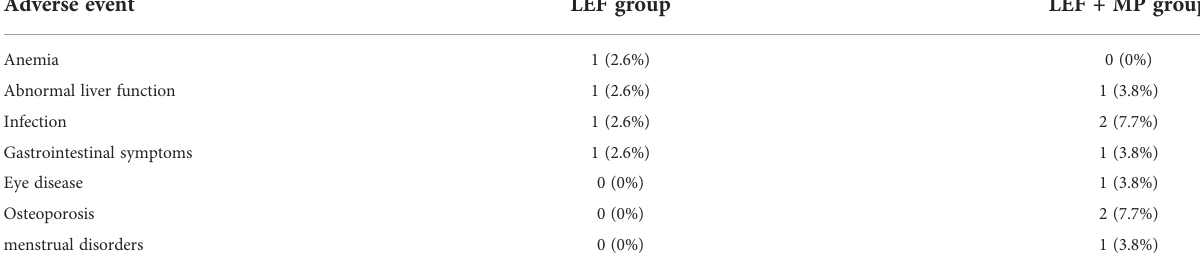
TABLE 4 Adverse events among the two groups. Adverse